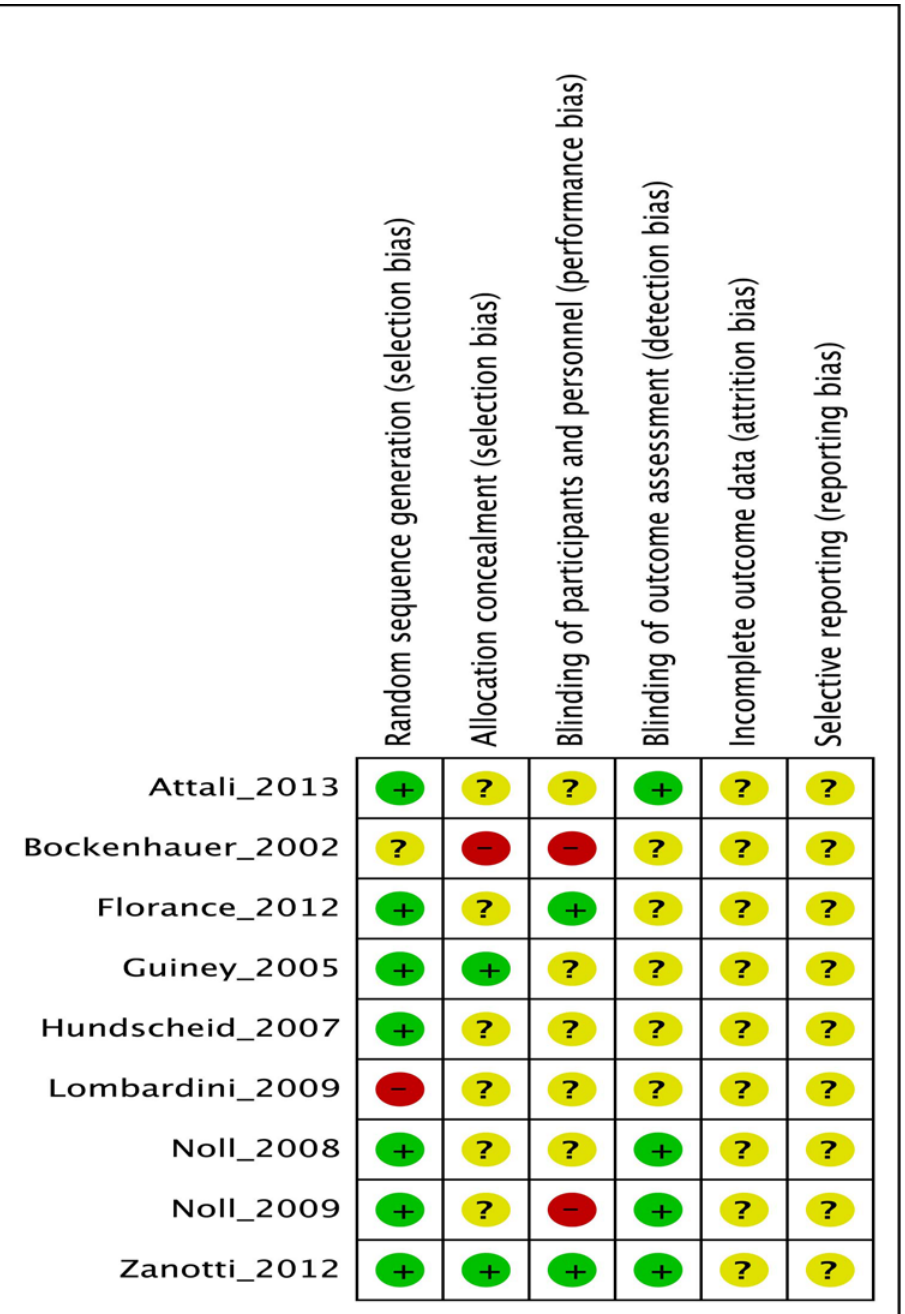
Fig 3. Risk of bias for included studies. +, low risk of bias;-, high risk of bias,?, unclear risk of